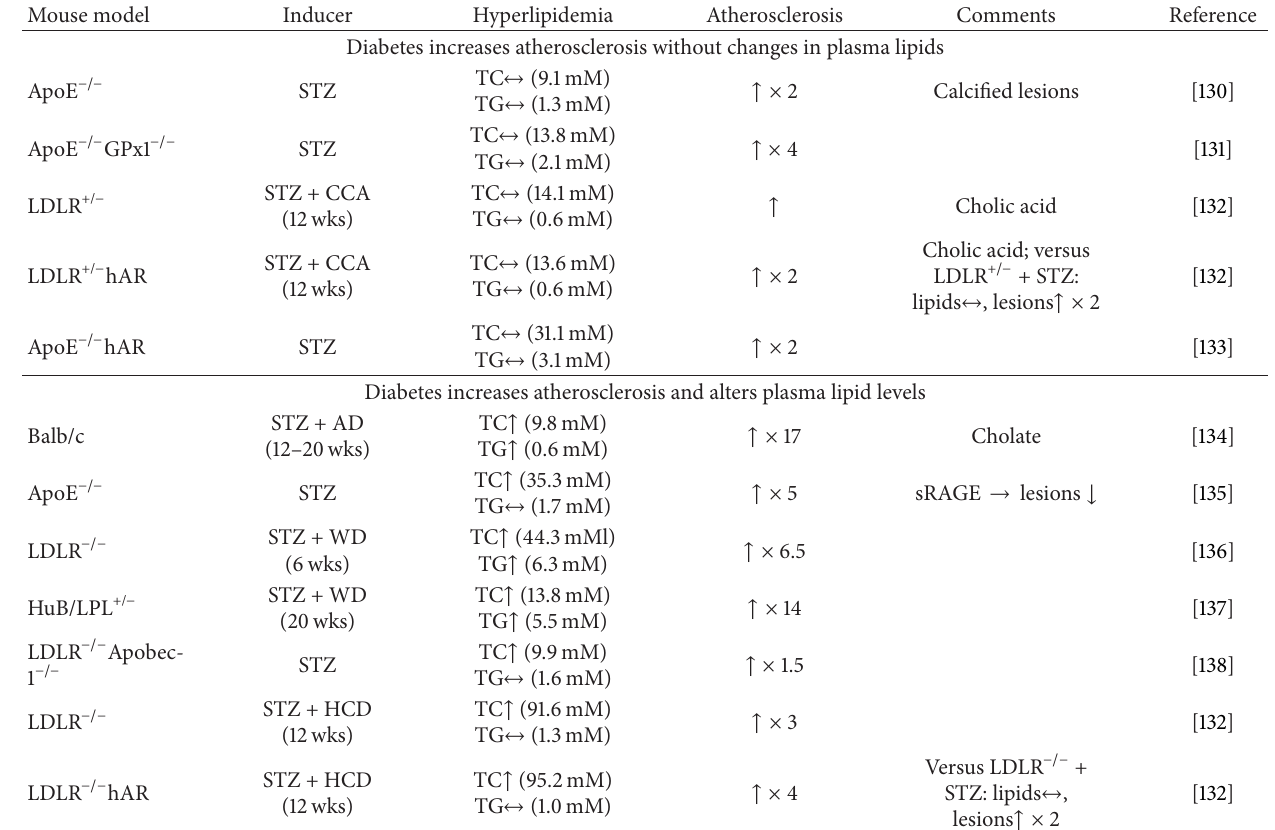
Table 3: Atherosclerotic mouse models with increased atherosclerosis after chemically induced diabetes. Mouse